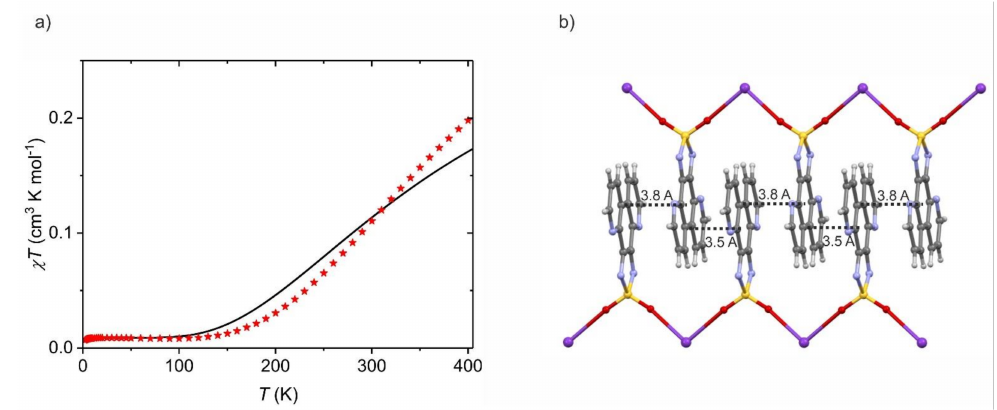
Figure 11. Typical χ T ( T ) dependence (red stars) recorded at 1000 Oe for K + [4,7-tdapO 2 ] − [42] ( a ) showing the importance of the π - π stacking interactions ( b ) as efficient magnetic interaction pathways. The solid line in ( a ) is a simulation assuming local antiferromagnetic interactions between two 4,7-tdapO 2 − radical anions ( g = 2.00) with J = − 250 cm − 1 ( H = − 2 JS 1 S 2